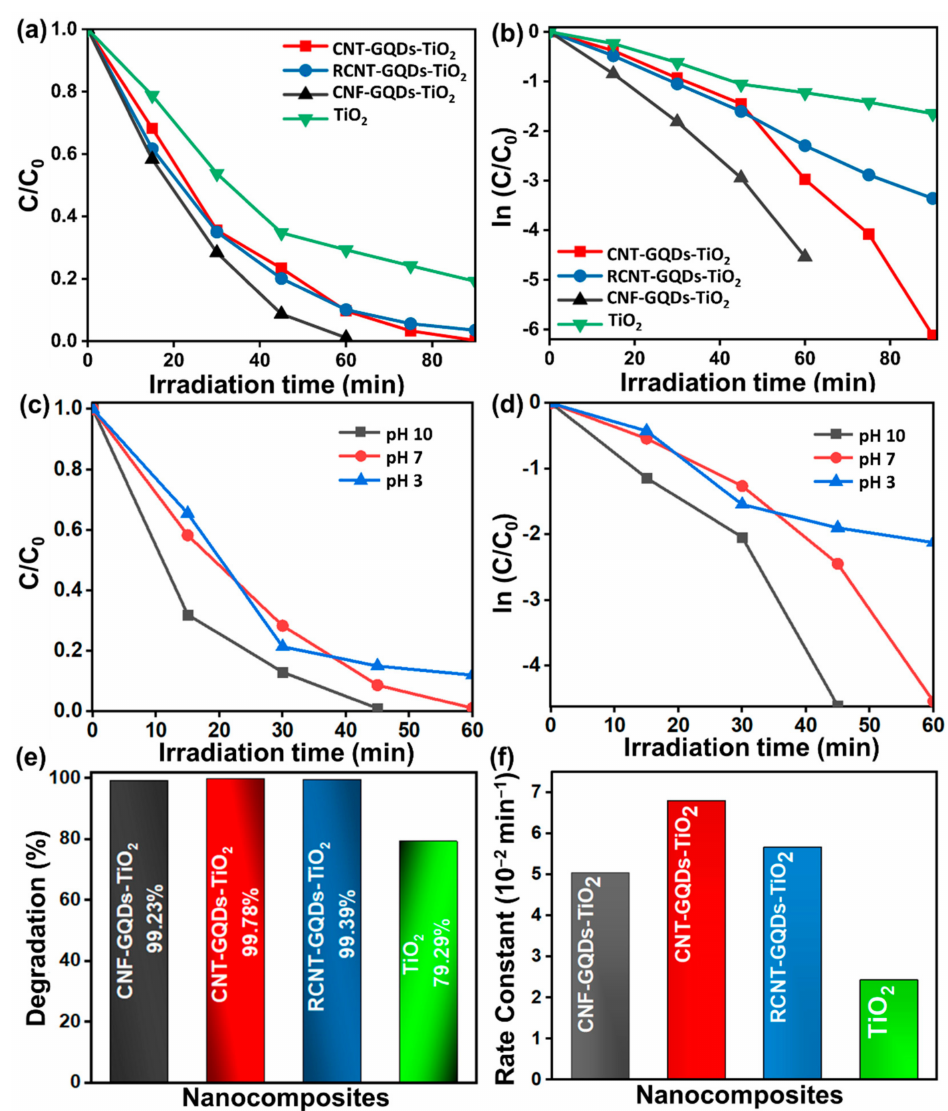
Figure 5. Visible light photocatalytic degradation of MB for as-synthesized GQDs-TiO 2 nanocompos- ites ( a ) Change in relative concentration (C/C0) of MB in GQDs-TiO 2 nanocomposites as a function of irradiation time up to 90 min, ( b ) Derived plot from same data to study ln(C/C0) variations with irradiation time. pH variation effect on the ( c ) Change in relative concentration (C/C0) as a function of irradiation time up to 60 min using CNF-GQDs-TiO 2 nanocomposites, ( d ) Respective derived plot of ln(C/C0) variations with irradiation time. ( e ) Comparison of MB degradation in different nanocomposites, ( f ) Comparative study of first order rate constants of as-prepared GQDs- TiO 2